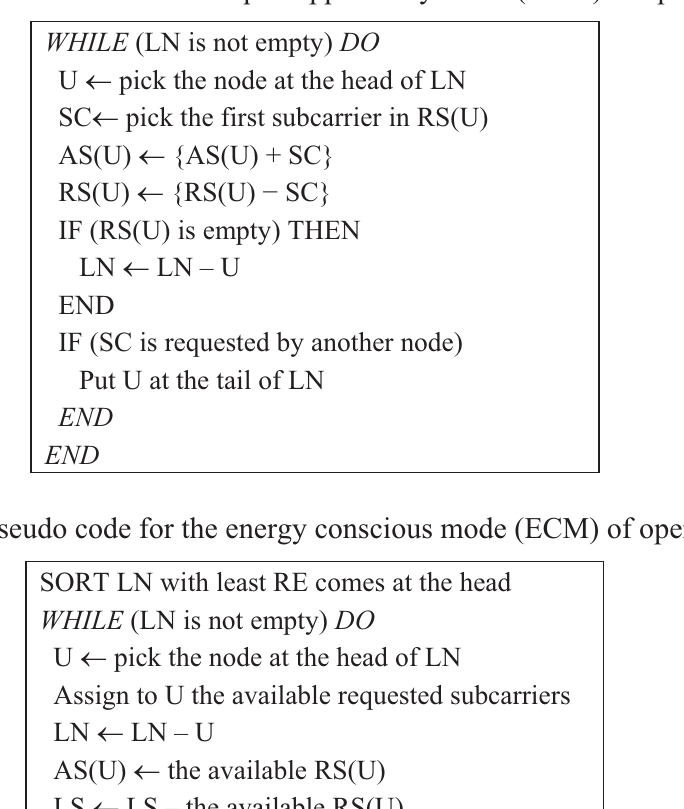
Table 2. Pseudo code for the equal opportunity mode (EOM) of operation.